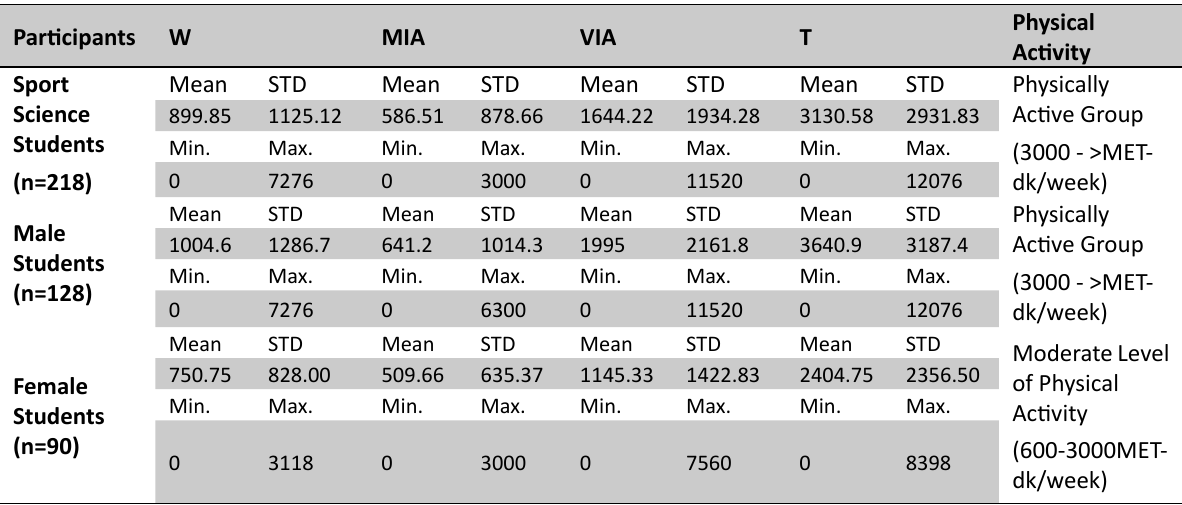
Table 2. Average, standard deviation and range variability values of the physical activity of the sport science students